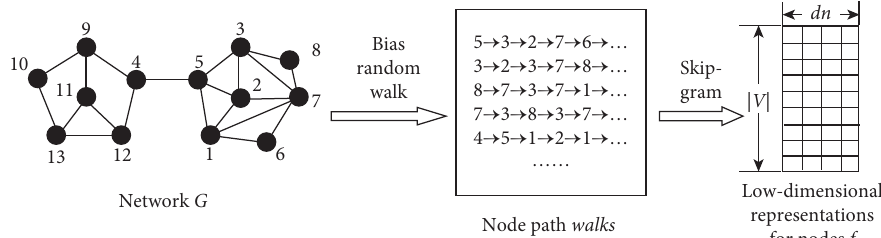
Figure 2: The illustration of